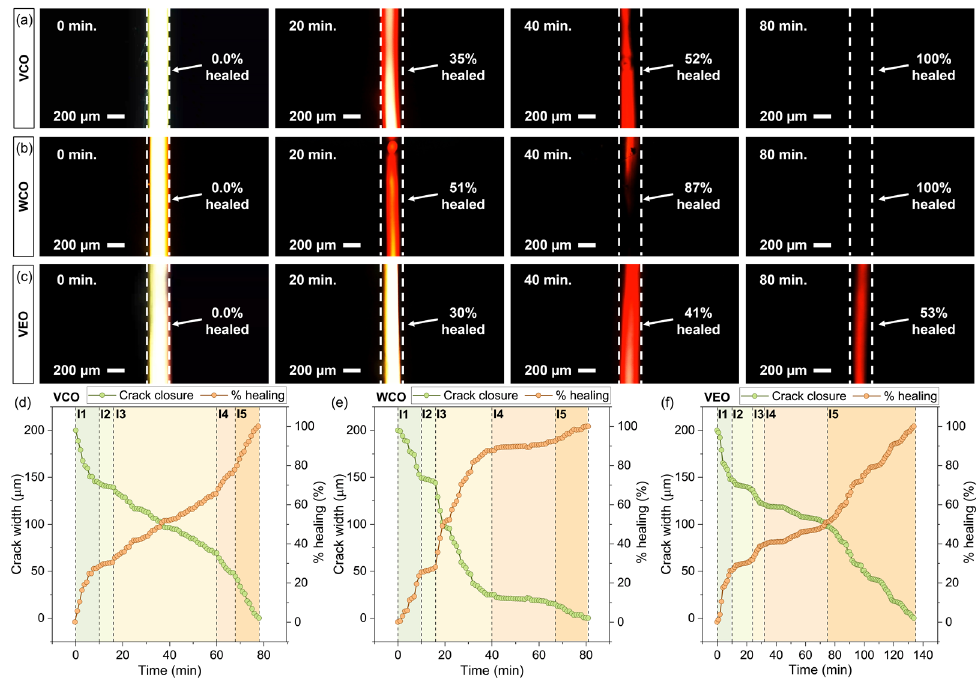
Figure 10. Fluorescence microscopy images for ( a ) VCO, ( b ) WCO, and ( c ) VEO asphalt rejuvenators on asphalt film samples at 0 min, 20 min, 40 min, and 80 min. Results of crack width and healing efficiency of bitumen samples rejuvenated with ( d ) VCO, ( e ) WCO, and ( f ) VEO over time. Table 5. Results of | 𝑅 𝑐 | values in µm/min for each interval and rejuvenated bitumen Sample